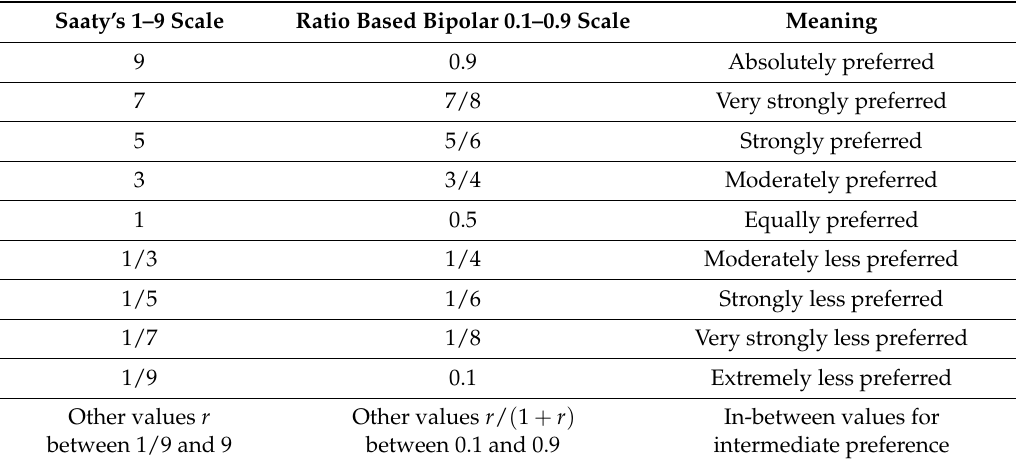
Table 1. Cross ratio based bipolar 0.1–0.9